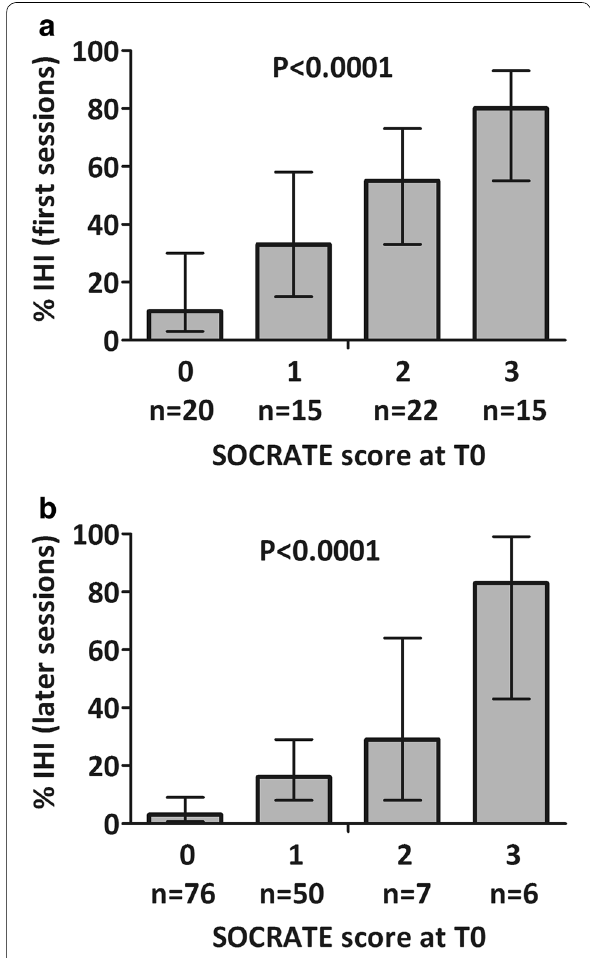
Fig. 1 Proportion of intradialytic hemodynamic instability (IHI) during first sessions ( a ) and later sessions ( b ) according to the SOCRATE score (cardiovascular SOFA score time 3 s and lactATE level > 2 mmol/L). Error bars represent 95% ≥ confidence